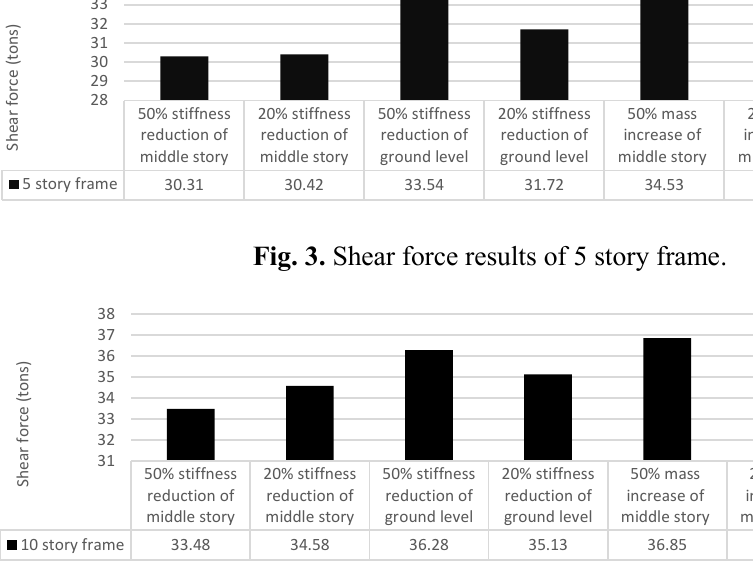
Fig. 4. Shear force results of 10 story frame.